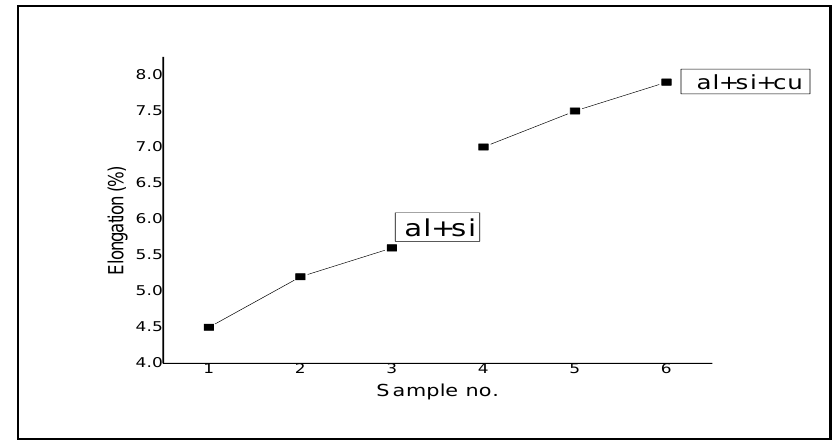
Figure 8: Curve showing variation of Young’s Modulus with sample no (Al19.5wt % Si, Al21wt % Si, Al22.5wt % Si, Al18wt % Si+1.5wt % Cu, Al19.5wt % Si +1.5wt % Cu, Al21wt % Si +1.5wt %